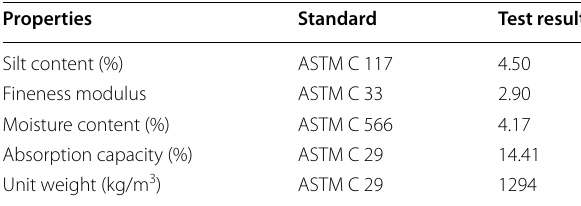
Table 1 Properties of fine aggregate.